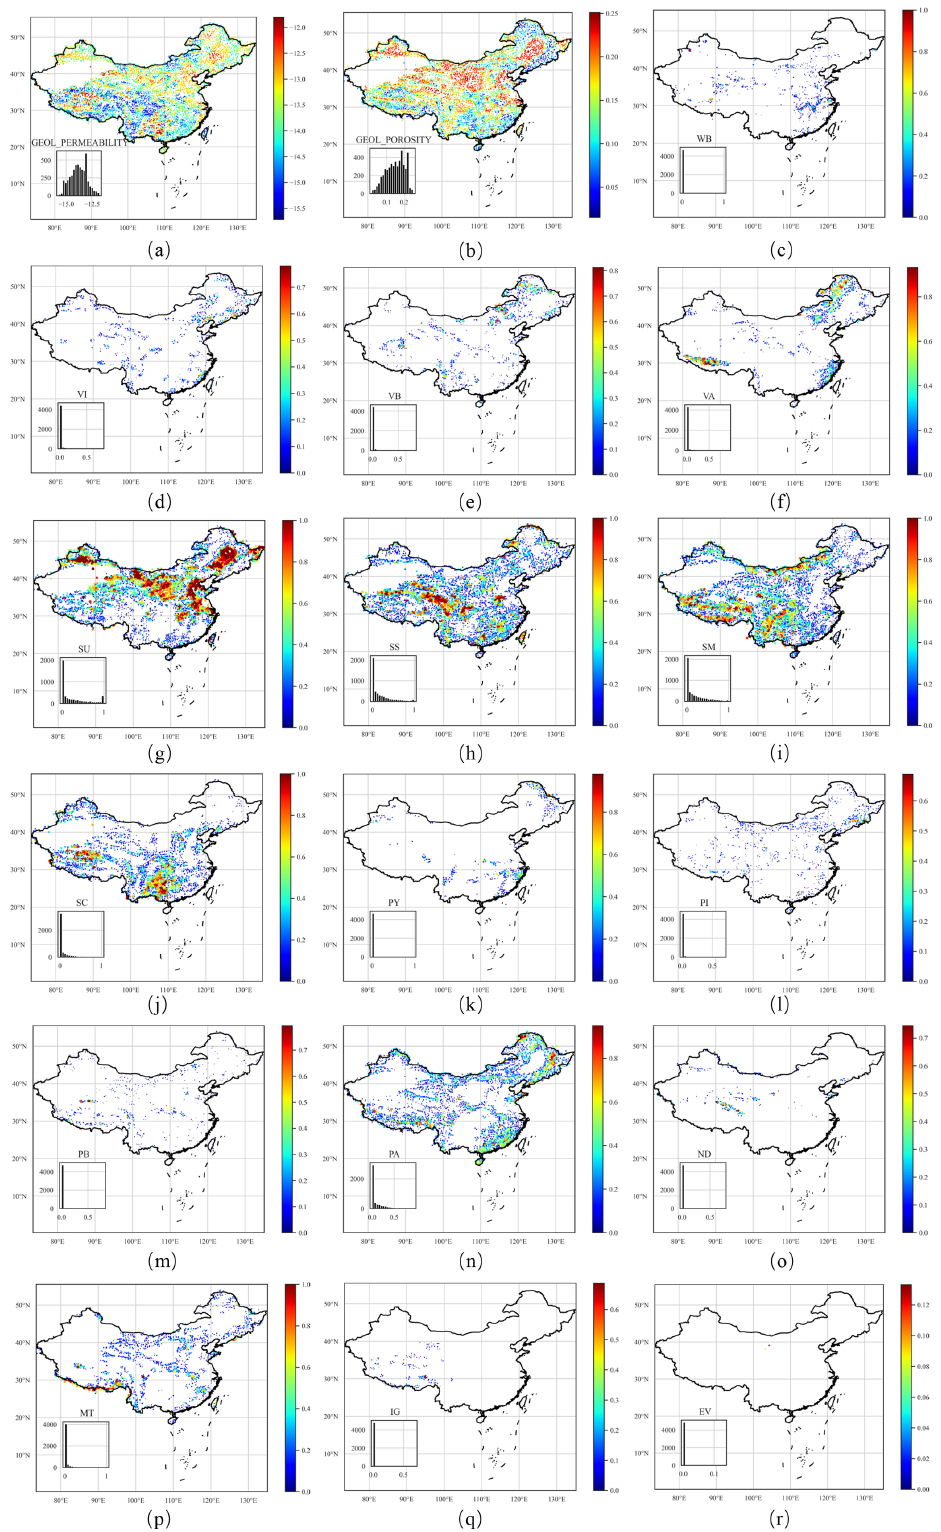
Figure 4. Distributions of geological characteristics throughout China. For lithologies, the plot size is scaled by the lithology proportion.